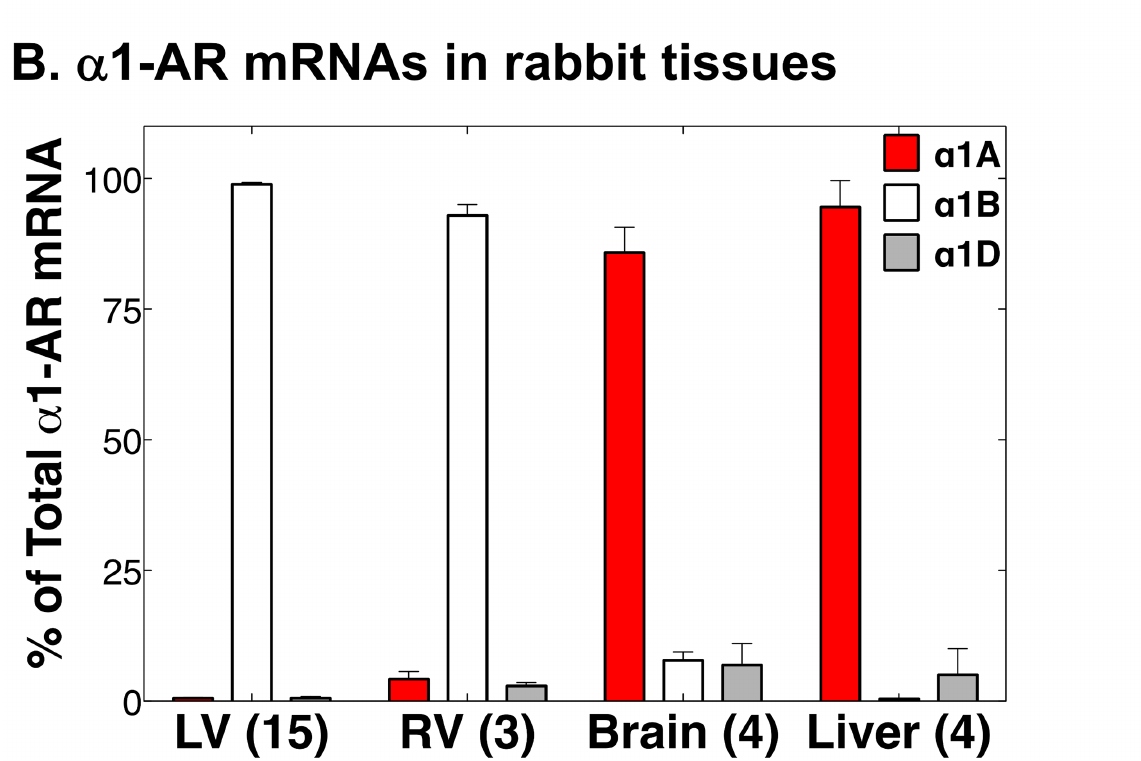
Fig 1. α 1A, B, and D subtype mRNAs in the rabbit heart. RNA from the indicated tissues was used in qPCR for the 3 α 1-AR subtype mRNAs. ( A ) Original PCR amplification curves for mRNA from a rabbit heart (left), with mouse heart for comparison (right), showing predominant α 1B in rabbit with much less α 1A and α 1D. Number of cycles is indicated on the X axis. ( B ) Group data showing % of total α 1-AR mRNA for each α 1-AR subtype in rabbit LV, RV, brain, and liver. Values are mean ± SE for the number of animals indicated. α 1A mRNA is a very low fraction of total in LV and RV, in contrast with brain and liver as positive controls for the primers and protocol. α 1A and α 1D mRNAs are somewhat greater in RV than LV, but this might be due to somewhat lower levels of the housekeeping genes in